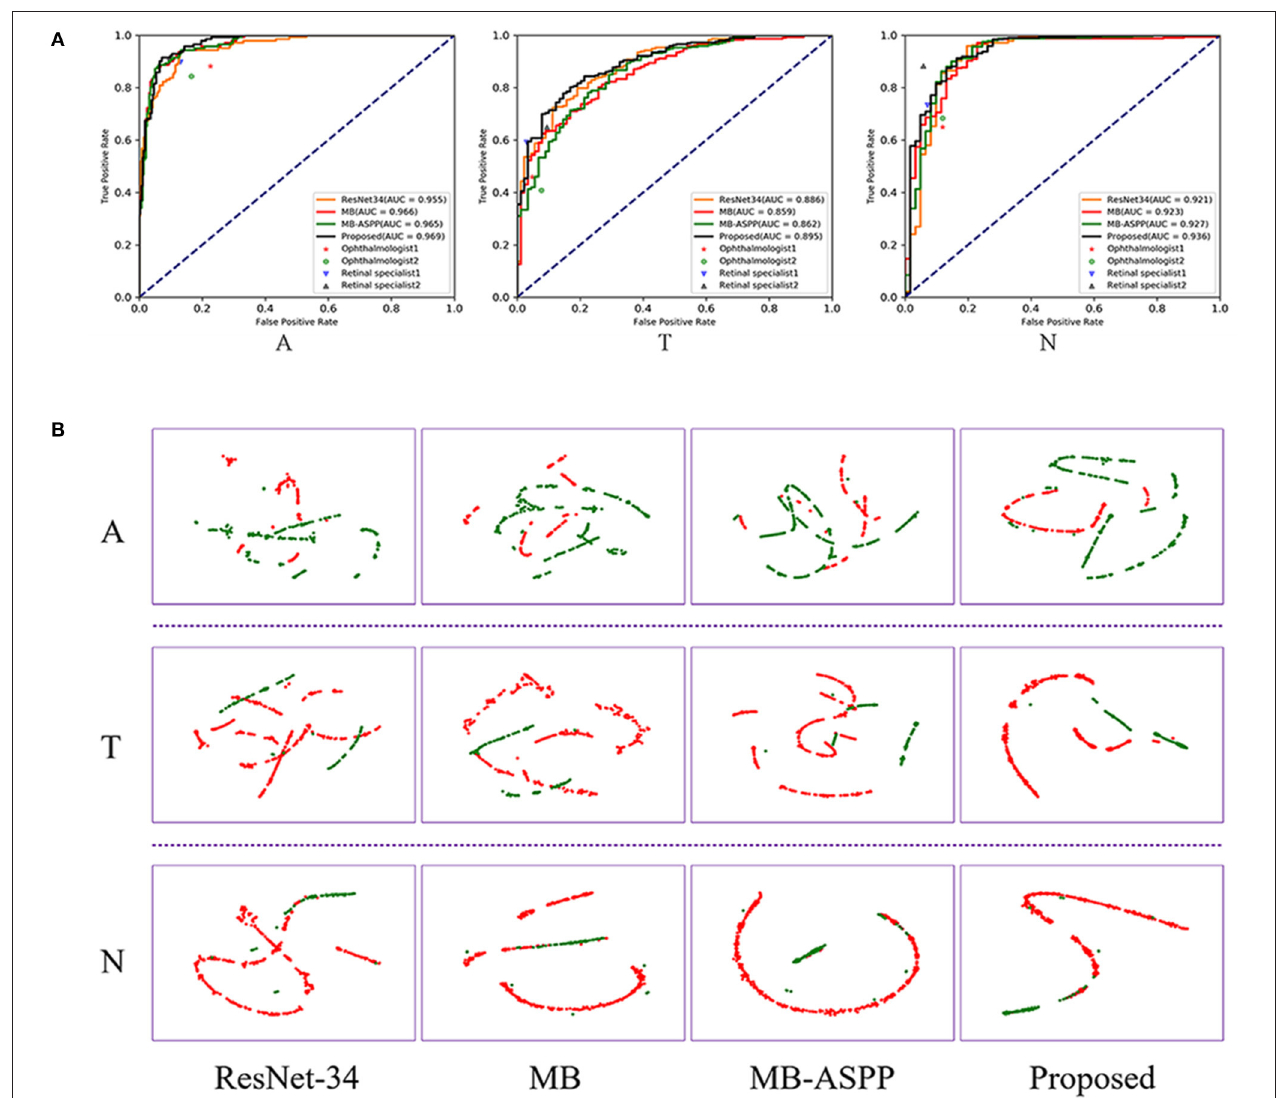
FIGURE 5 | Performance of AI system in A, T, and N categories. (A) The comparison of different methods and clinicians using ROC curves. AUC, area under the curve; ROC, receiver operating characteristic. (B) The t-SNE visualization of different methods. Red and green points represent negative and positive results, respectively.